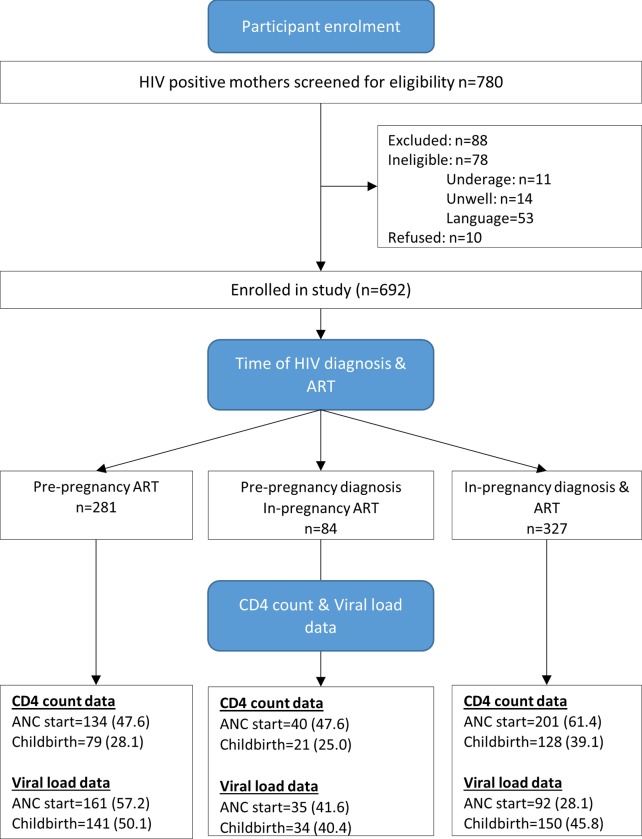
CONSORT diagram of retrospective cohort and data completeness.